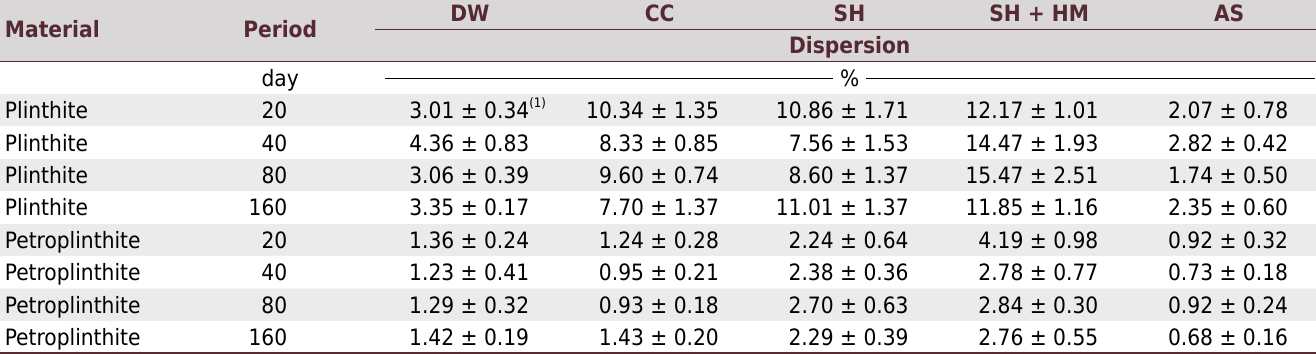
Table 5. Mean and standard error of the mean dispersion of plinthite and petroplinthite subsamples in the soil profiles, immersed in different solutions for different periods